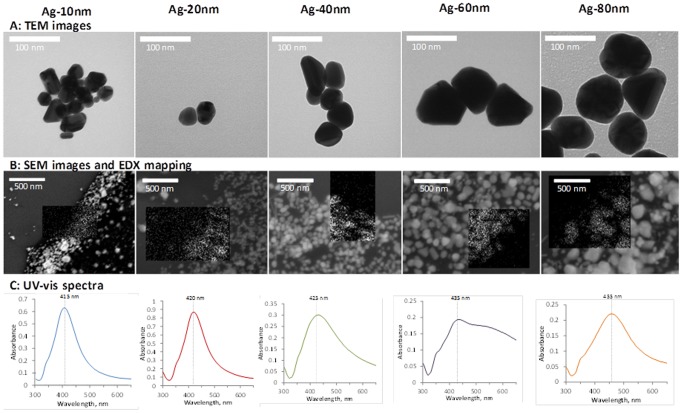
Electron microscopy images and UV-Vis absorption spectra of the studied citrate-stabilised Ag nanoparticles.A: TEM photos of the particles; B: SEM photos with EDX mapping; C: UV-Vis absorption spectra (Ag-10 nm 8 mg/L, Ag-20 nm 11 mg/L, Ag-40 nm, Ag-60 nm and Ag-80 nm 5 mg/L in ultrapure (UP) water. Maximum absorption is indicated with a vertical dotted line; wide absorption spectrum indicates polydispersity of the sample.